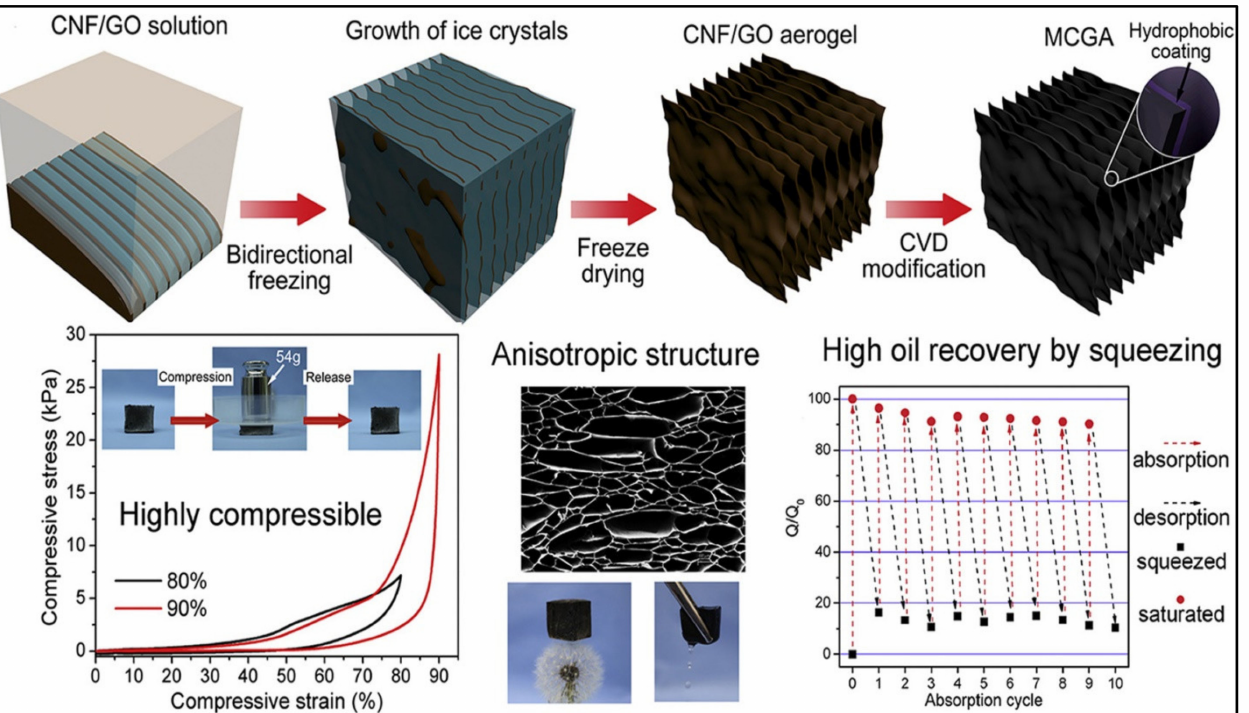
Figure 7. Illustration of the fabrication steps of compressible, anisotropic and elastic nanocellu- lose/graphene aerogel, showing its high oil recovery by squeezing. Adapted from [94], with permis- sion from Elsevier,